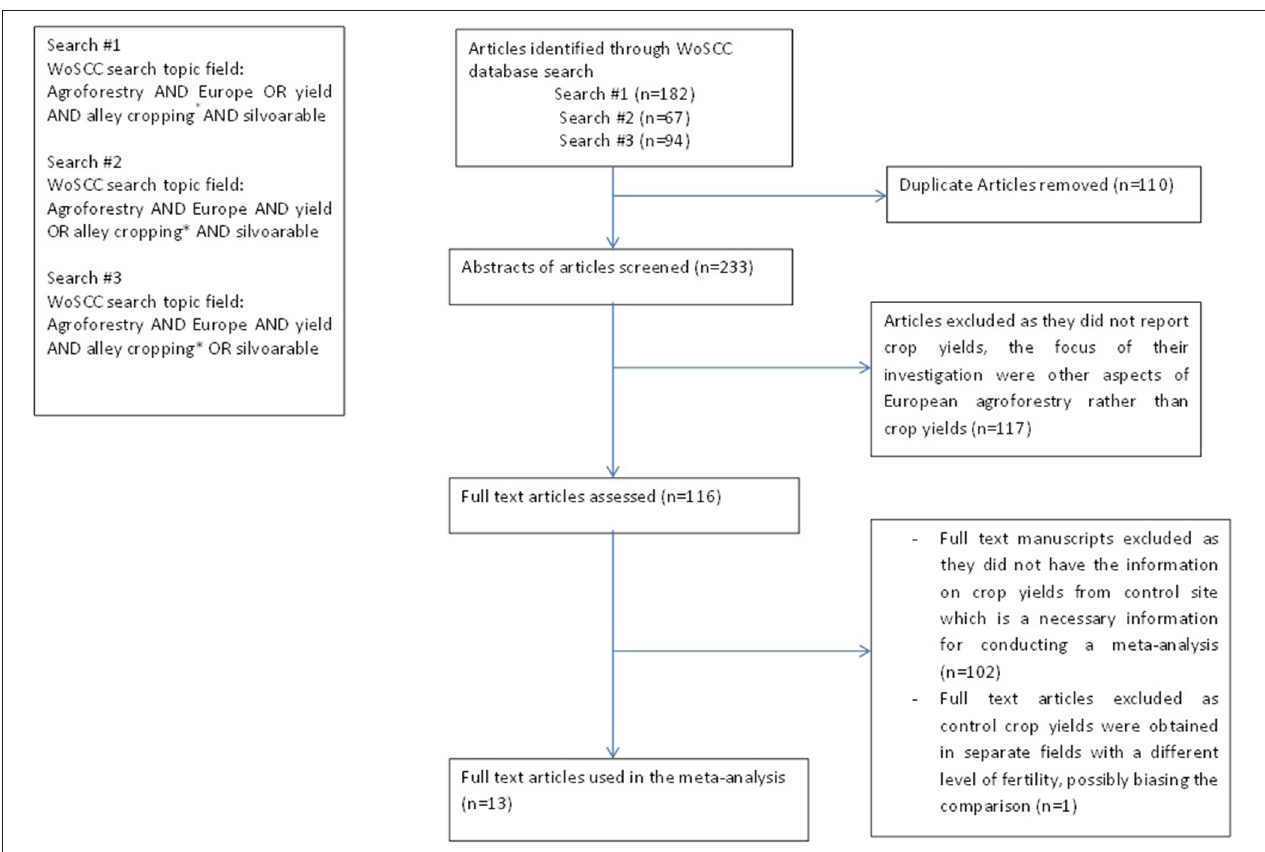
FIGURE 1 | PRISMA diagram—Description of literature search and article selection